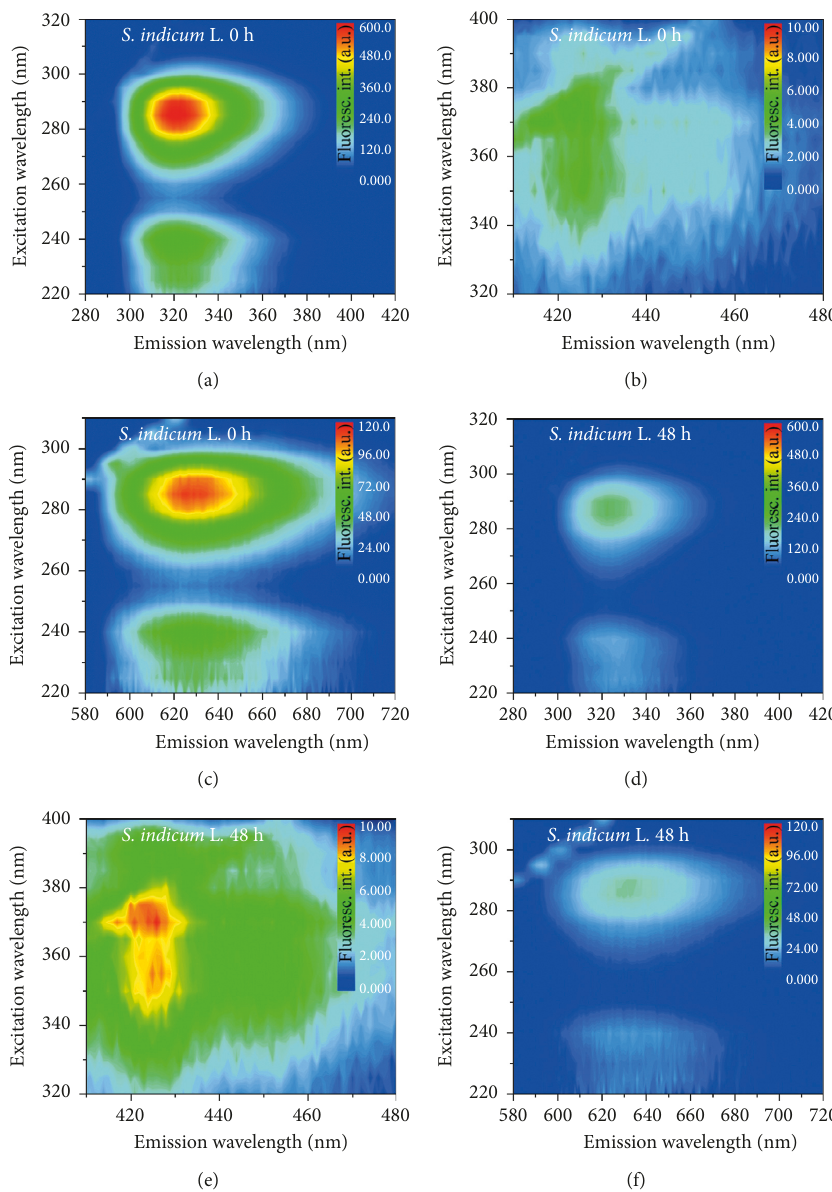
Figure 4: Fluorescence intensity maps of S. indicum L. biodiesel (a, b, c) before the oxidative process and (d, e, f) after 48h of degradation. Scattering not